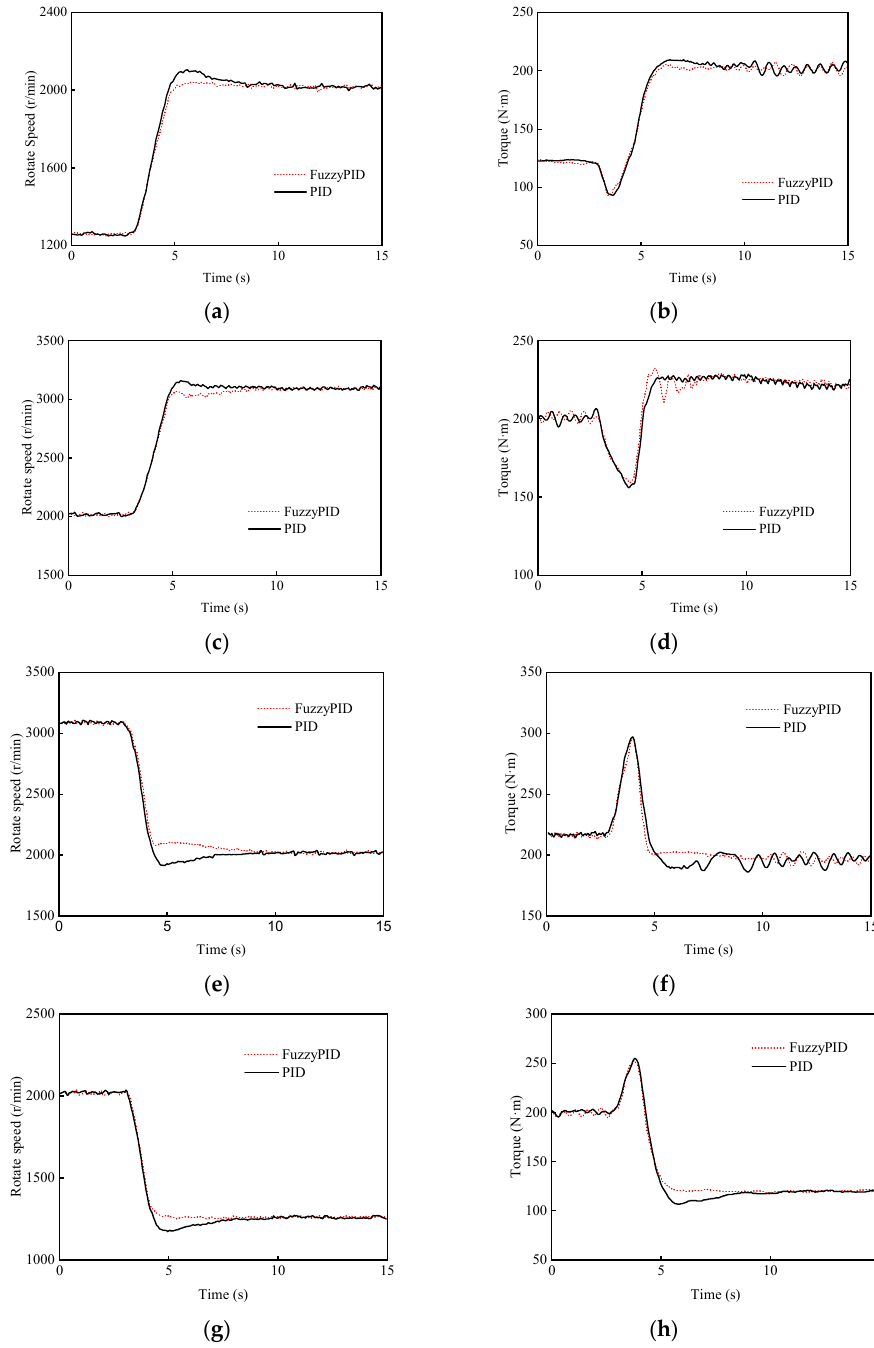
Figure 4. Variation in speed and torque during the process of working condition switching: ( a ) Change in speed during switching 1. ( b ) Change in torque during switching 1. ( c ) Change in speed during switching 2. ( d ) Change in torque during switching 2. ( e ) Change in speed during switching 3. ( f ) Change in torque during switching 3. ( g ) Change in speed during switching 4. ( h ) Change in torque during switching